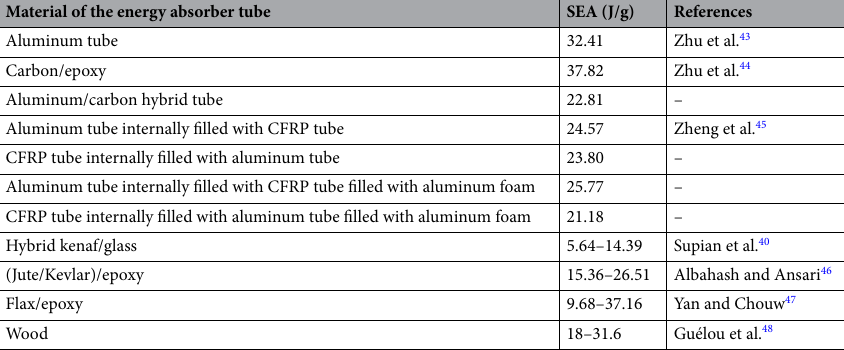
Table 5. SEA for some metallic and fiber reinforcement composite tubes (labeled in the literature).